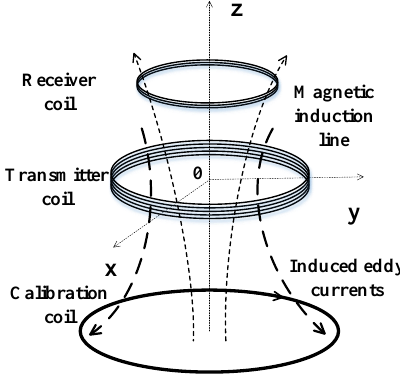
Figure 6. Response model based on a conductive loop. The TX coil is arranged in the z = 0 plane, and a conductive ring used as the secondary field source is coaxially placed in the z = −h plane below the TX coil.